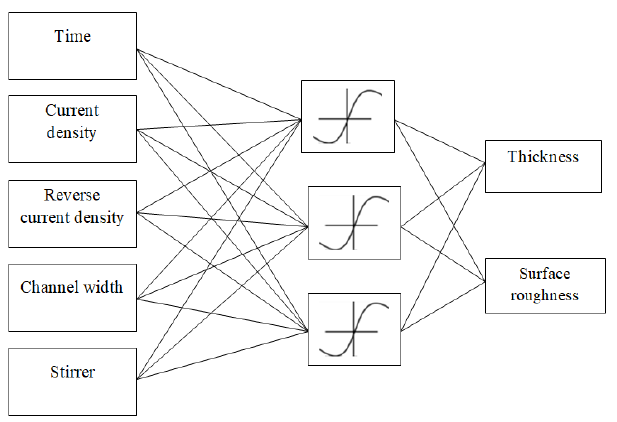
Figure 5. Neural network configuration.